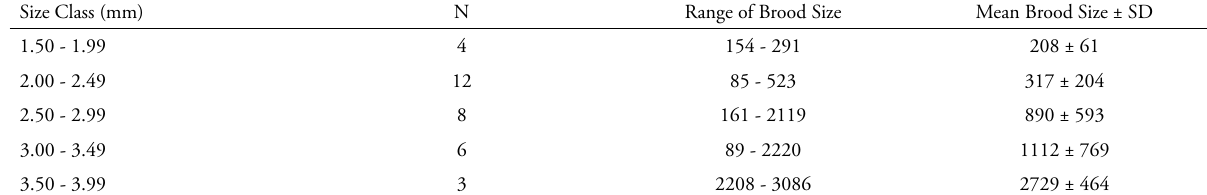
Table 4. Urobopyrus processae . Mean brood size based on female parasite size class.